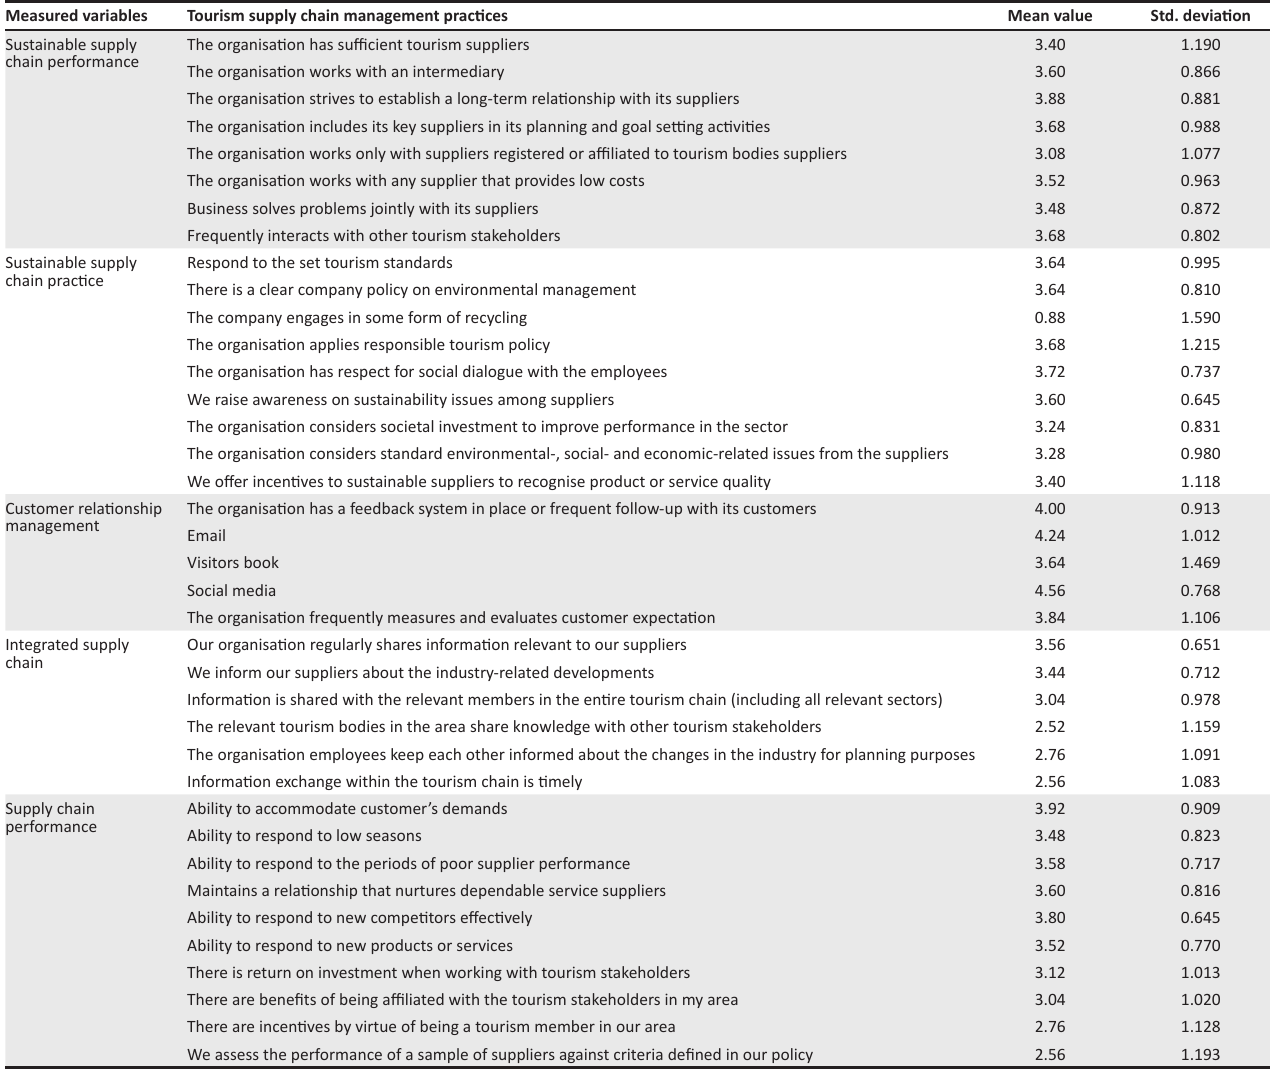
TABLE 1: Tourism operations supply chain drivers and barriers . Measured variables